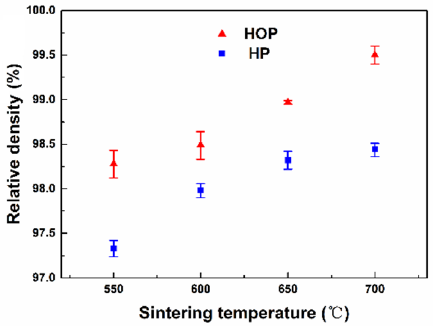
Figure 3. A plot of relative density as a function of sintering temperature for samples sintered by HOP and HP, respectively.